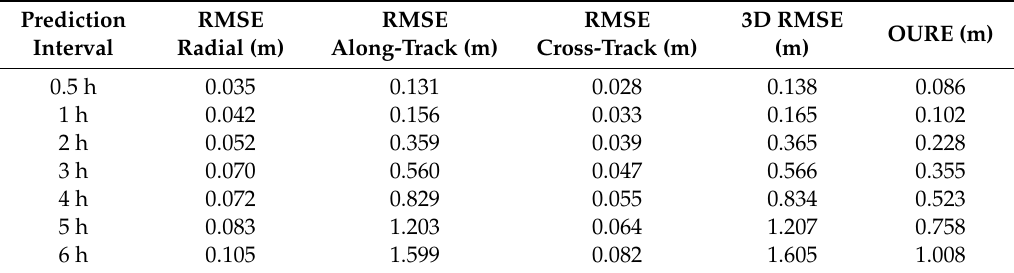
Table 6. The prediction error budget for different prediction intervals when using the dynamic model having stochastic velocity pulses set up for every 2 h (Table 2).